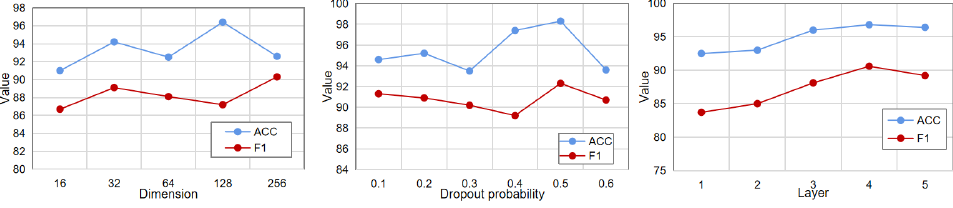
Figure 4. Parametric analysis.